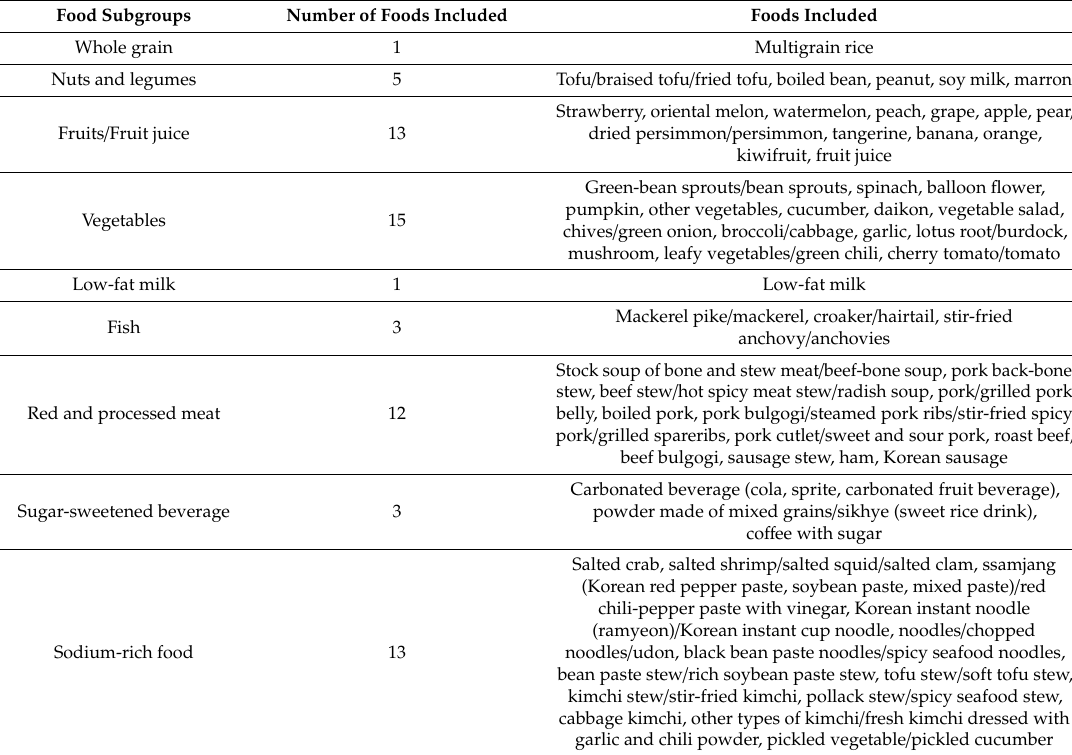
Table 1. Foods or food groups in the